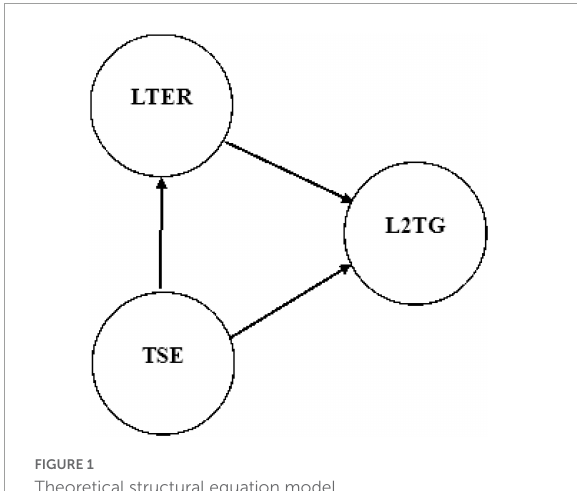
FIGURE1 Theoretical structural equation